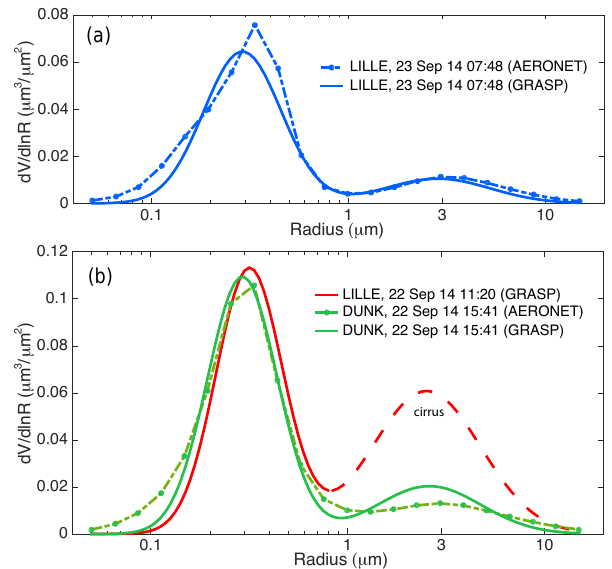
Figure 4. (Top) Consistency of the volume size distribution (VSD) in Lille on 23 September retrieved (dashed line) by inversion of Almucantar observations using standard AERONET inversion and (solid line) by inversion of direct sun measurements using GRASP algorithm. (Bottom) For 22 September, consistency of VSD re- trieved by inversion of almucantar using standard AERONET in- version in Dunkerque (green dashed line) and by inversion of direct sun measurements using GRASP algorithm in Dunkerque (green plain line) and Lille (red line).